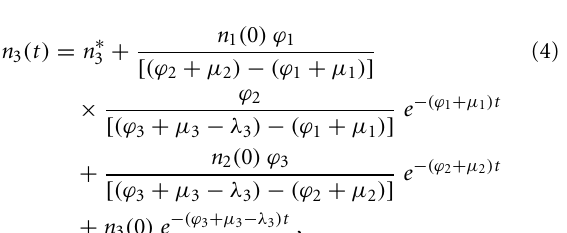
thymocytes have two fates: further differentiation into the SP pool ( ϕ 2 ) or death by apoptosis ( µ 2 ). Finally, SP thymocytes have three fates: maturation and exit into the periphery ( ϕ 3 ), death by apoptosis ( µ 3 ), or proliferation ( λ 3